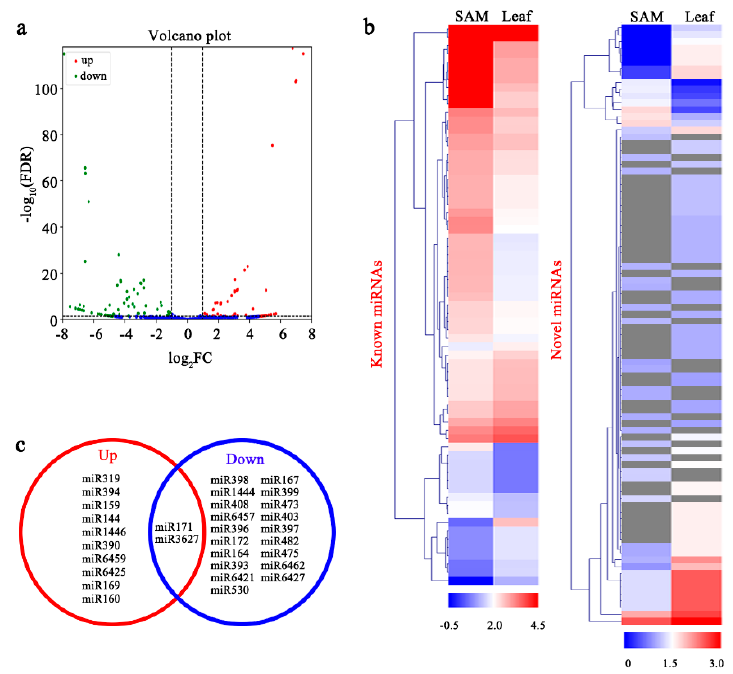
Figure 4. Differentially expressed miRNAs. ( a ) Scatter diagram of the differential read counts of the known and novel miRNAs. Each dot in the figure represents one miRNA. Red and green dots represent differentially expressed miRNAs. ( b ) Hierarchical cluster and expression profile analyses of the differentially expressed known and novel miRNAs between the shoot apical meristem (SAM) and leaves. Each column represents a sample, and each row represents a single miRNA. The hierarchical cluster was obtained using MultiExperiment Viewer (MeV). The data in the heatmaps are the values of log 10 transcripts per million (TPM). The bar indicates the expression scale for miRNAs in the SAM and leaves; grey represents non-expressed miRNAs. ( c ) Known miRNA families up- and down-regulated in the SAM compared with leaves.